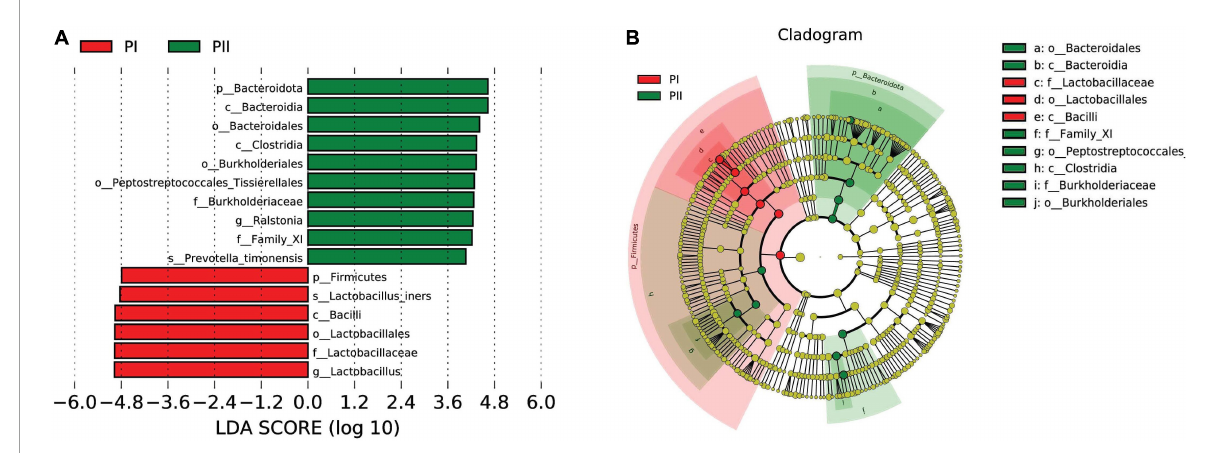
FIGURE5 Biomarker between PI and PII. (A) Enrichment in microbial taxa with a threshold of LDA score > 4. LDA scores obtained from the LEfSe analysis of the vaginal microbiota in PI and PII groups. LDA, linear discriminant analysis; LEfSe, LDA effect size analysis. (B) Cladogram of the vaginal microbiota in PI and PII groups. The microbial compositions were compared at different evolutionary levels.